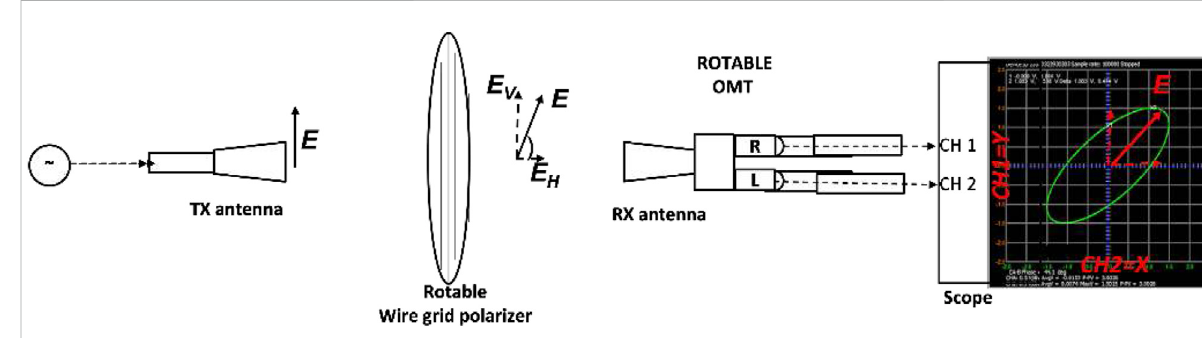
FIGURE 7 Scheme of the free-space setup for measuring the Lissajous ’ s fi gures.